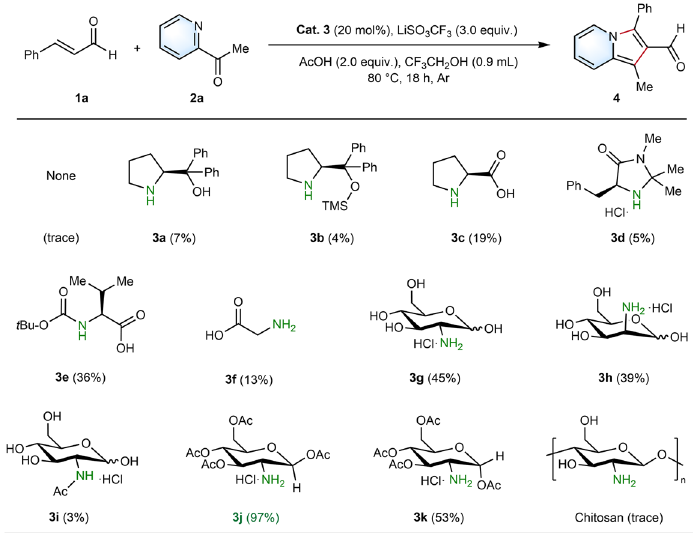
Fig. 2 Optimization of the aminocatalyzed [3 + 2] annulations for indolizine-2-aldehyde. a 1a (0.2 mmol), 2a (2.5 equiv.), aminocatalyst (20 mol%), LiSO 3 CF 3 (3.0 equiv.), AcOH (2.0 equiv.), CF 3 CH 2 OH (0.9 mL), Ar, 18 h, 80 °C. b Yields were determined by 1 H-NMR analysis with CH 2 Br 2 as internal standard. Chitosan has a degree of deacetylation of